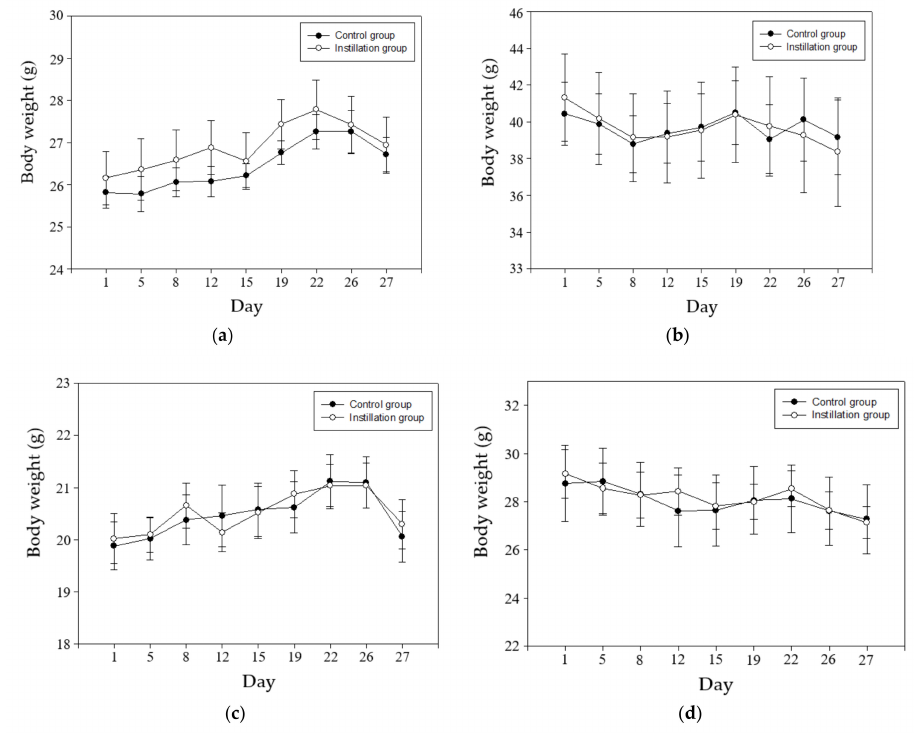
Figure 2. Body weight (mean ± SE) change in vehicle (control) or Diesel Exhaust Particle (DEP) instilled in mice. ( a ) Young male mice (8-week-old); ( b ) Old male mice (40-week-old); ( c ) Young female mice (8-week-old); ( d ) Old female mice